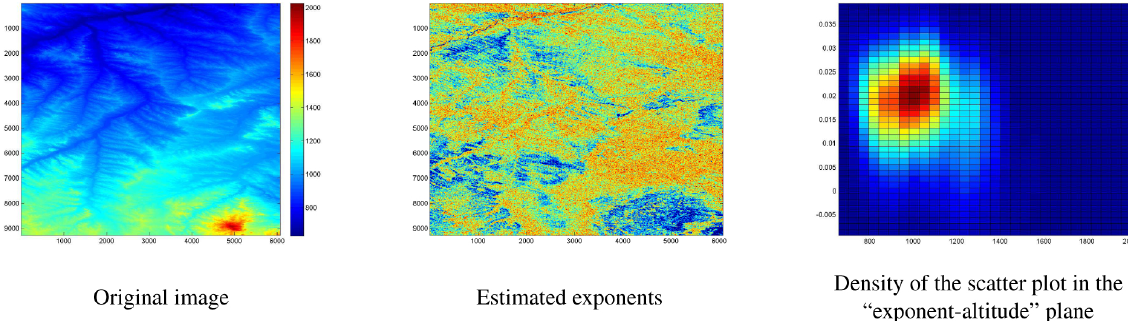
Fig. 8. Altitude, Pointwise H¨older regularity and phase plane for the Rocky Mountains Fig. 8. Altitude, pointwise H¨older regularity and phase plane for the Rocky Mountains.